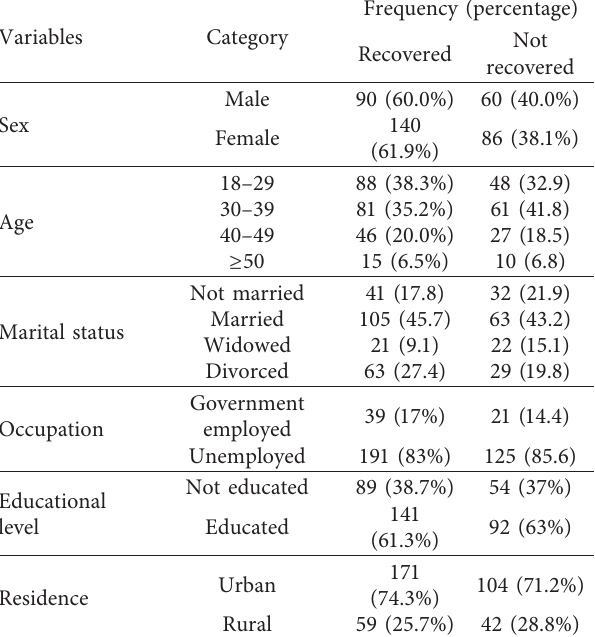
Table 1: Sociodemographic characteristics of malnourished HIV patients, Finote-Selam Hospital, Northwest Ethiopia, January